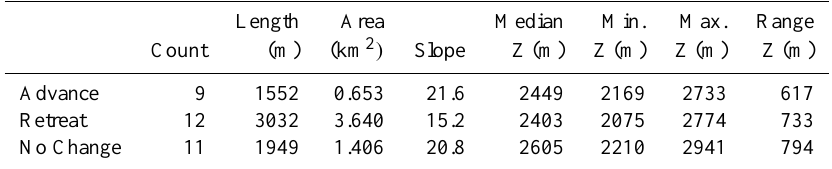
Table 4. Median glacier morphometry for glaciers that underwent some advance, receded continuously, or exhibited no discernable change during the period 1952–1985. Length Area Median Min. Max.